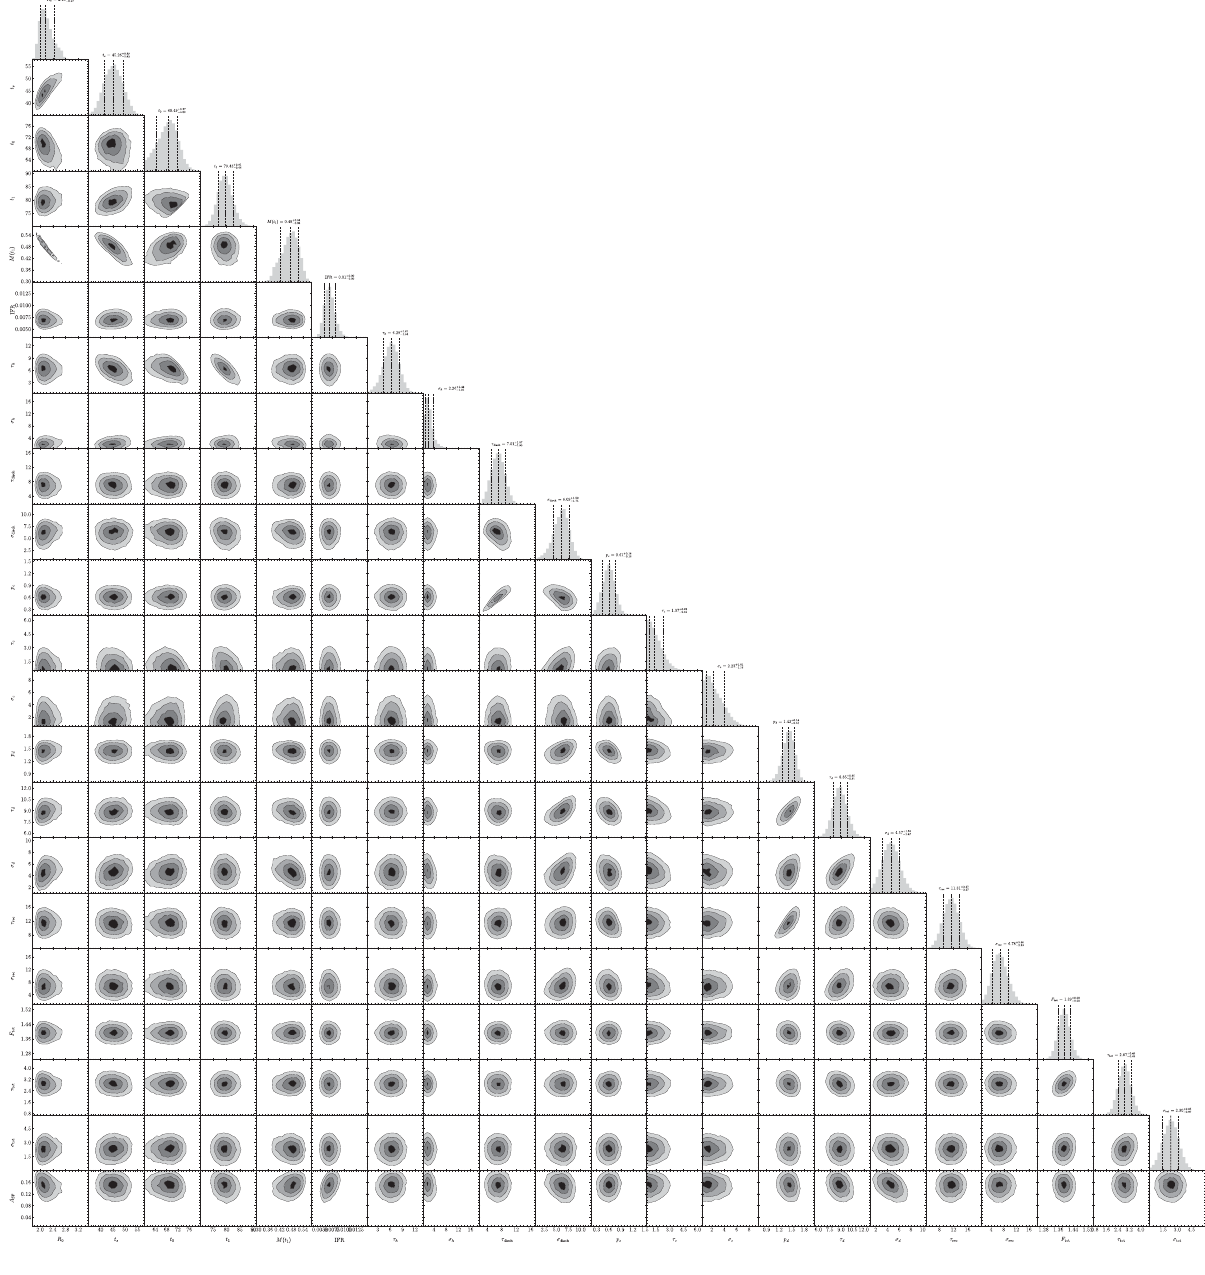
FIG. 11. Joint posterior distributions of pairs of the complete set of parameters of our model fitted to the all-state data up to May 17, 2020. The correlations between some pairs of fitted parameters such as, e.g., between R 0 and the start date of the epidemic are reflected in the ellipsoidal shape of the posteriors. This figure is an expanded version of Fig.